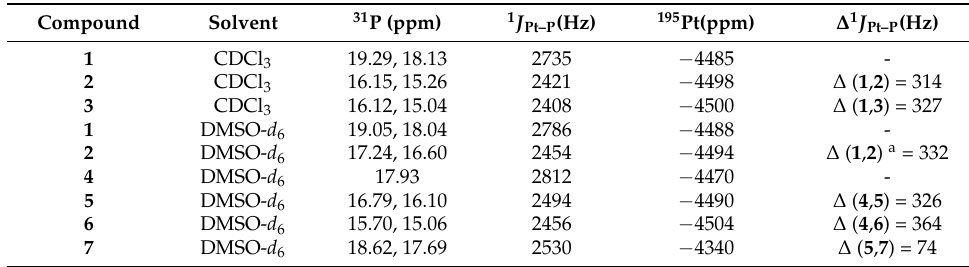
Table 1. 31 P{ 1 H}and 195 Pt NMR data for complexes 1 – 7